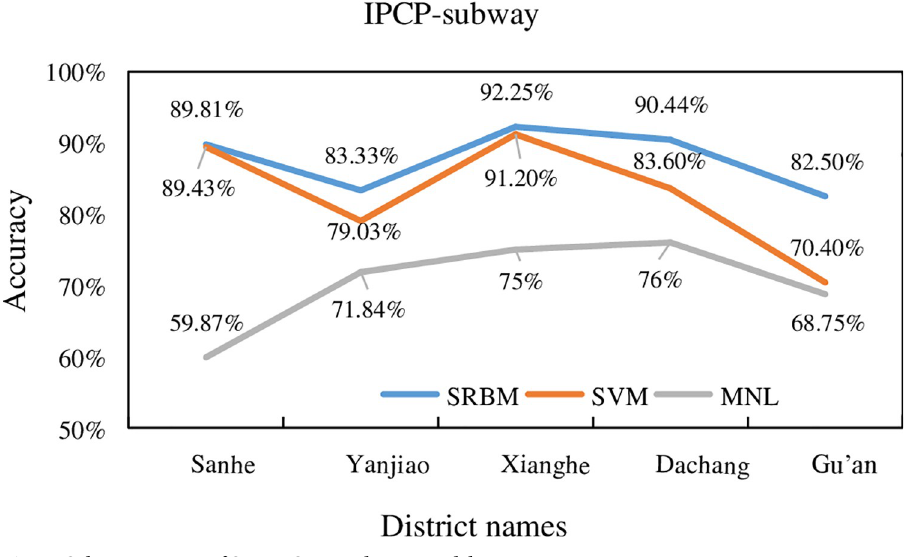
Fig 10. Subway accuracy of SRBM, SVM and MNL